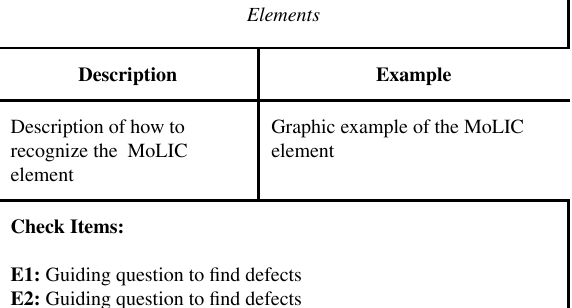
Table 1. Template - Cards of checked MCheck Items (Damian